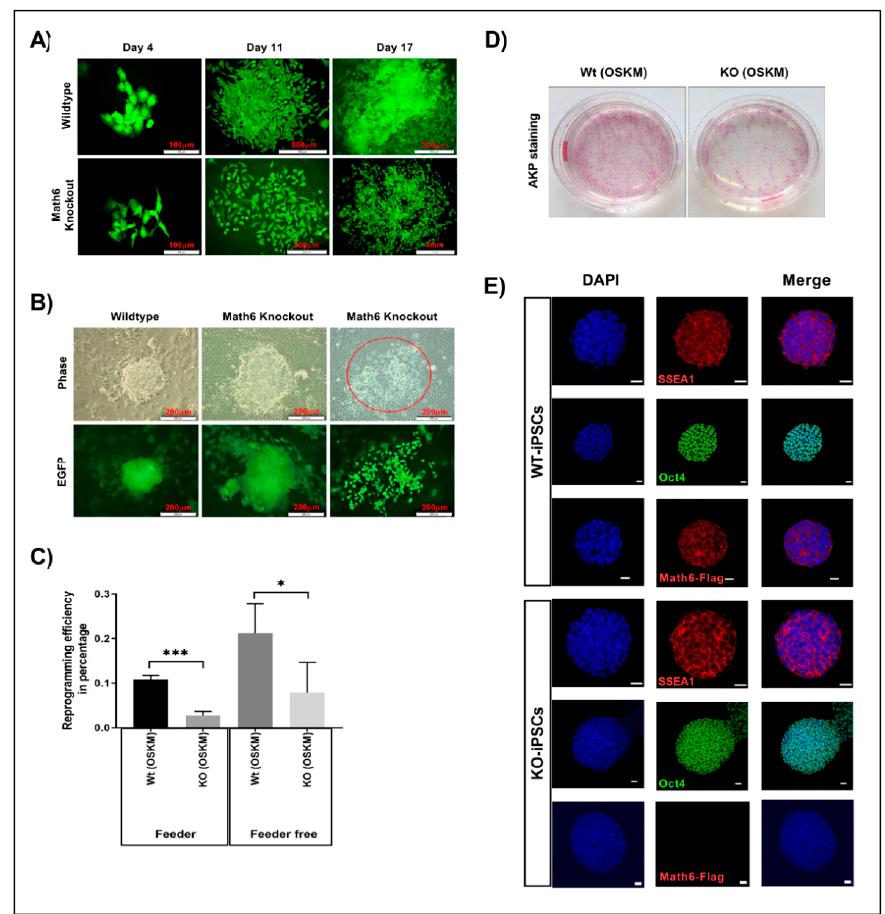
Figure 2. Math6 promotes somatic cell reprogramming. ( A ) Comparison of wildtype and Math6 knockout reprogramming on the feeder. Wildtype (WT) cells could undergo reprogramming on the feeder, whereas knockout (KO) cells failed to undergo proper reprogramming on the feeder. ( B ) Comparison of wildtype and Math6 knockout reprogramming performed on Matrigel on Day 14. Both WT and KO fibroblasts could undergo reprogramming. However, in Math6 knockouts we can see both successfully reprogramming colonies and cells that failed to form colonies with dispersed morphology (marked red). ( C ) Reprogramming efficiencies of reprogramming performed on feeder and Matrigel are shown. The statistical significance was determined by the Holm Sidak method t-test using Prism 8. Significance levels are shown as * p ≤ 0.05, ** p ≤ 0.01 and *** p ≤ 0.001. Hereafter, the statistical reprogramming e ffi ciency in wildtype and Math6 knockout on Day 20 of reprogramming (Feeder-free). ( E ) Immunofluorescence images of iPS cell lines derived by reprogramming fibroblasts as follows WT (OSKM), KO (OSKM). iPSC colonies positive for SSEA1 (red), Oct4 (green) and Math6—Flag (red) and DAPI (blue) are shown. Scale bar indicates 20 µ